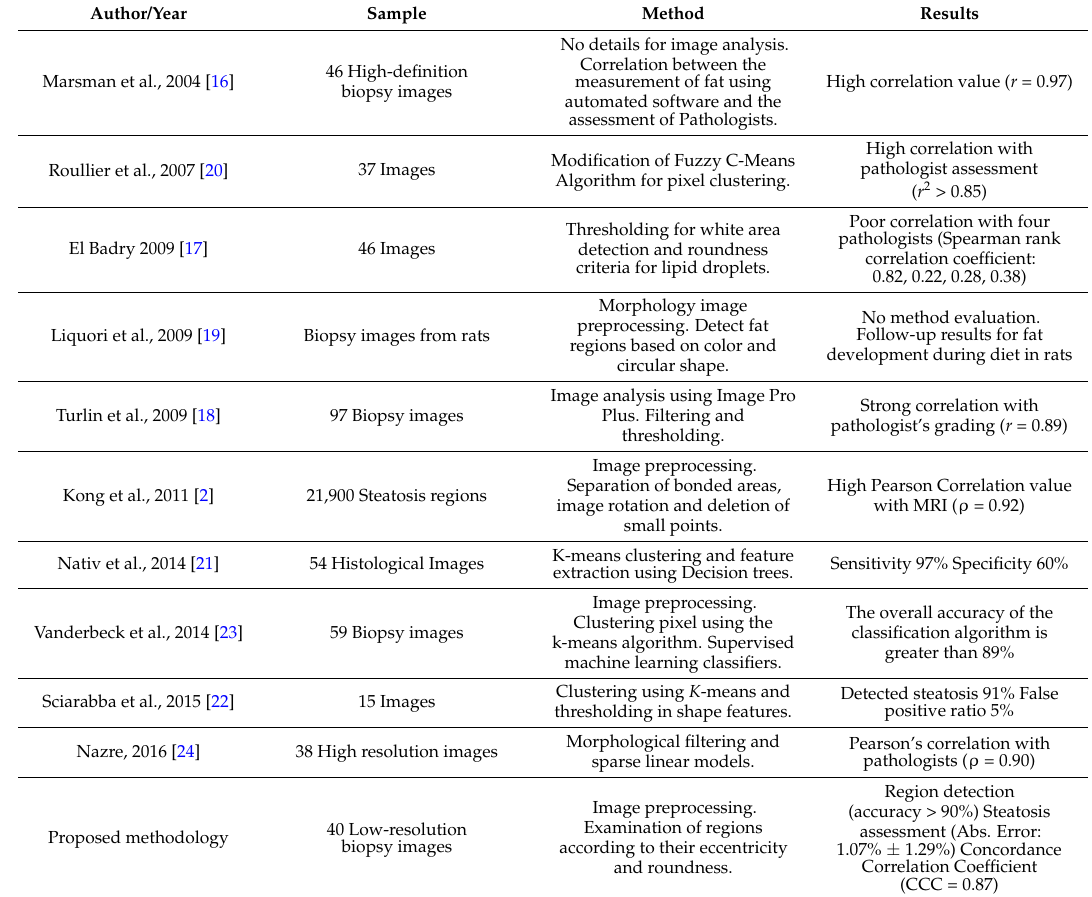
Table 3. Comparison with other methods from the